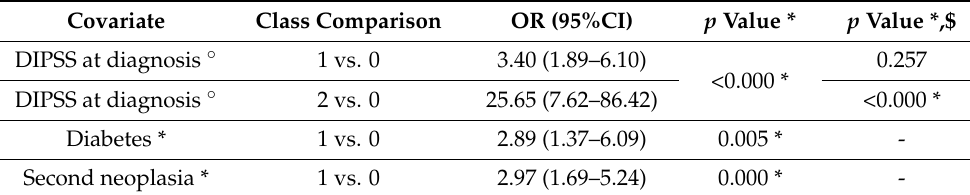
Table 5. Multivariable analysis considering the association between covariates and patients’ outcome (occurrence of death). Number of patients analysed: